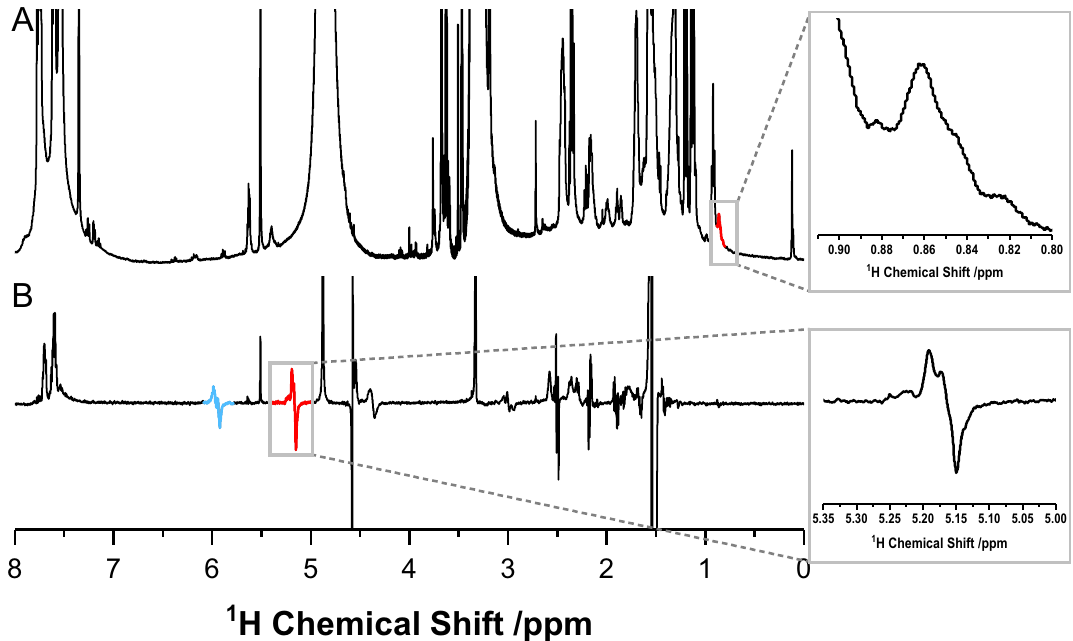
Figure 3. Comparison of the 1 H-NMR spectra of ( A ) the thermally relaxed spectrum after full hydrogenation (4096 scans) and ( B ) the PHIP spectrum (single scan) after addition of para -H 2 (enrichment of > 95%) (500 MHz, MeOH-d4, 298 K). The PHIP spectrum reveals hyperpolarized lines of the catalyst system (see Supplementary Fig. 10) and the strongly PHIP enhanced signal of the labeled eptifibatide, which is visible in the single scan spectrum with a good signal-to-noise ratio. The obtained enhancement factor, estimated from the insets for the signal at 5.17 ppm is above 1000 (see Supplementary Information for